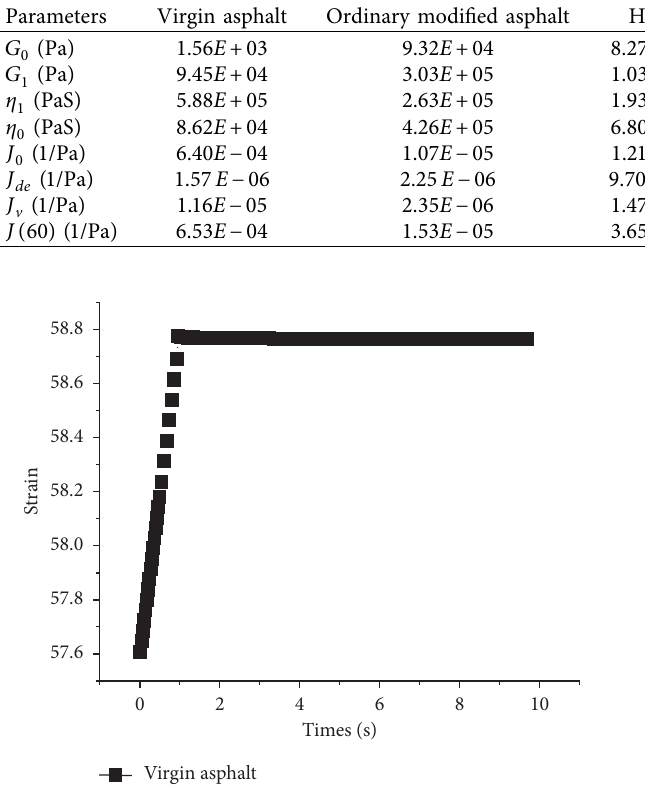
Figure 4: Creep-recovery response of virgin asphalt.